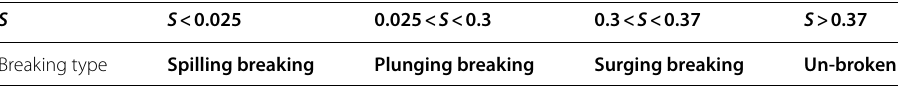
Table 1 Classification of wave-breaking proposed by Grilli (1997) S S > 0.37 Breaking type Spilling breaking Plunging breaking Surging breaking